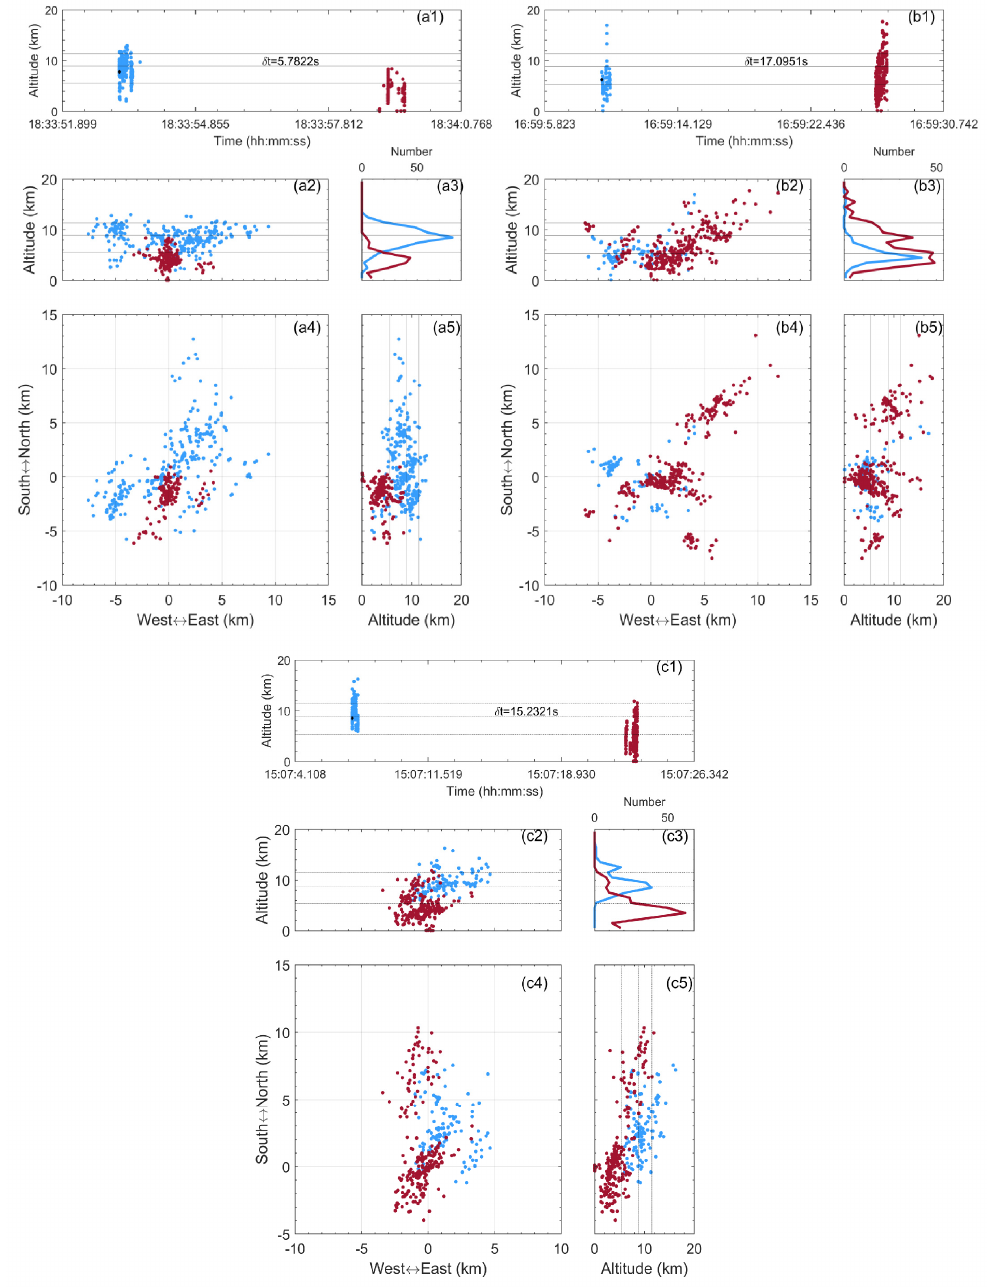
Figure 10. TLFs (in red color) and their corresponding NLFs (in blue color) initiated within a 5 km radius of the flash-triggered position and 20 s prior to the TLFs. ( a ): TLF named T20160609183358 and its corresponding NLF; ( b ): TLF named T20160615165926 and its corresponding NLF; and ( c ): TLF named T20170710150722 and its corresponding NLF. ( a1 – a5 ), ( b1 – b5 ) and ( c1 – c5 ) Subplot information is the same as in Figure